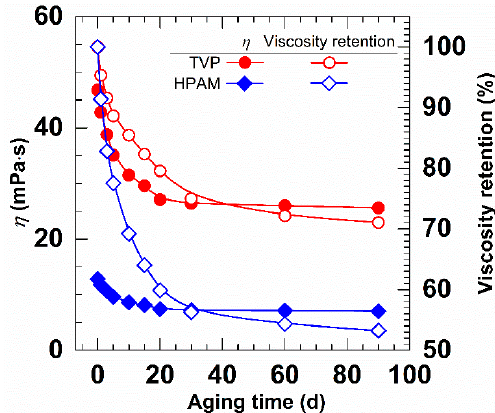
7 of 15 Figure 4 . The apparent viscosity of 0.1% TVP and HPAM solutions with 950 mg/LTDS plotted against shear rate at 25 °C. In general, the 0.1% TVP solution displays very similar shear flows to the HPAM solution; in particular, they have an almost superimposed shear thinning response, implying that TVP has comparable injection potential to HPAM. 2.4. Long-Term Thermal Stability Normally, it takes more than half a year for the polymer solution slug to pass from the injection wells to the production ones, so it is vital to see if the apparent viscosity can be sustained after long-term aging during this transportation process, and to see if the remaining viscosity is sufficient to control the mobility of a polymer slug over a water one. Compared in Figure 5 are the residual viscosity and viscosity retention for 0.1% TVP and HPAM solutions after different aging times under the simulated Daqing type III oil reservoir conditions. Both the TVP and HPAM solutions descend clearly over the aging time. After 20 days of aging at 45 ° C, the viscosity of both polymer solutions stabilizes,